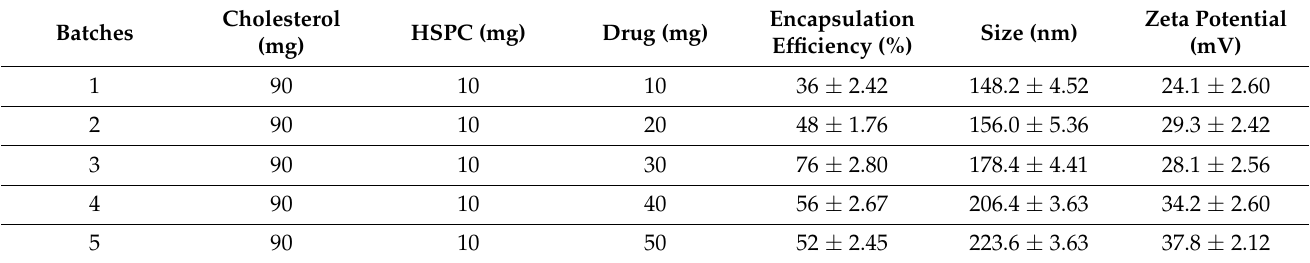
Table 1. Composition of different batches of liposomes prepared and results of encapsulation efficiency, size, and zeta